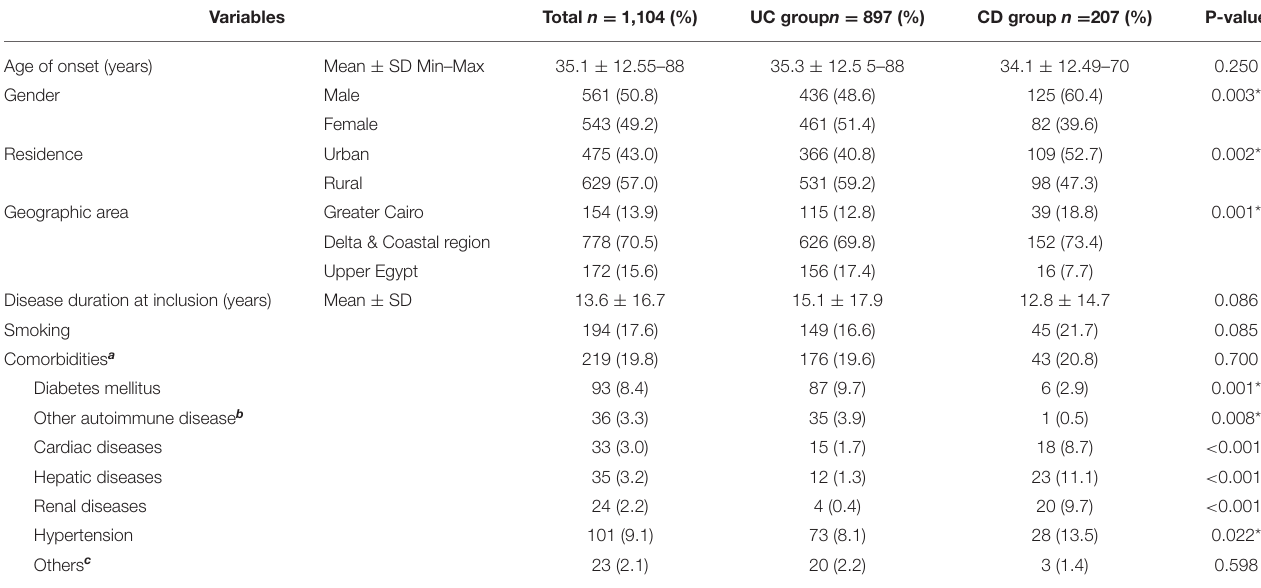
TABLE 1 | General characteristics of patients with inflammatory bowel disease in Egypt (May 2018 to August